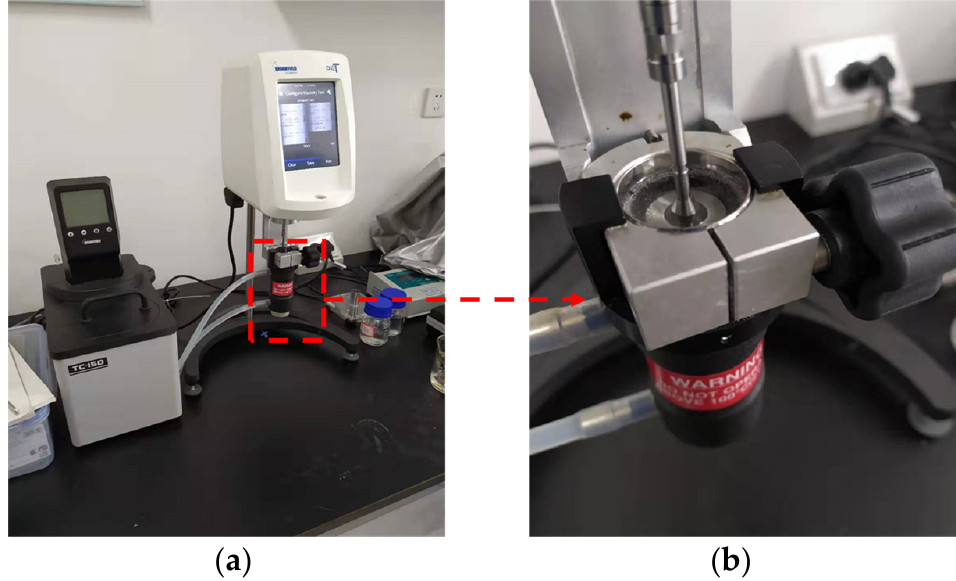
Figure 4. Viscosity test of sealant. ( a ) Brinell rotational viscometer. ( b ) Sealant test status.